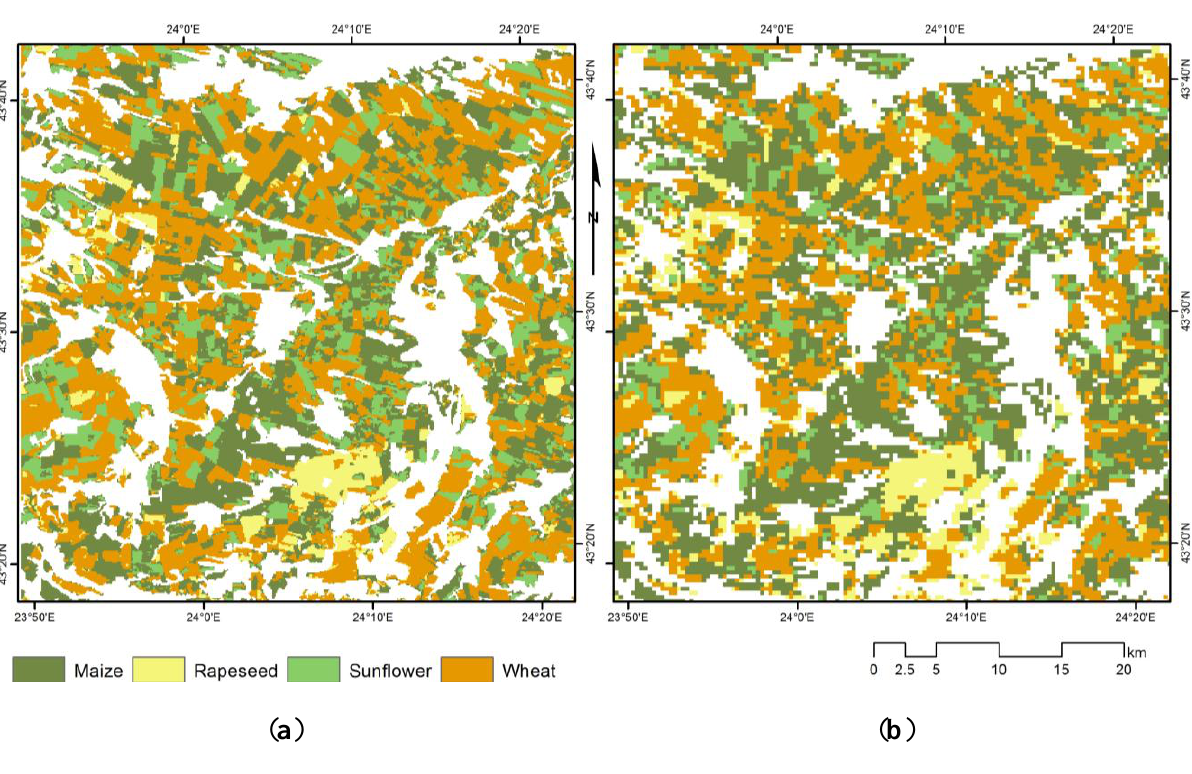
Figure 5. Crop map with four classes for PROBA-V NDVI ( a ) 100 m and ( b ) 300 m time series from unsupervised ISODATA clustering. Note that areas outside the CORINE class 211 (non-irrigated arable land) were left